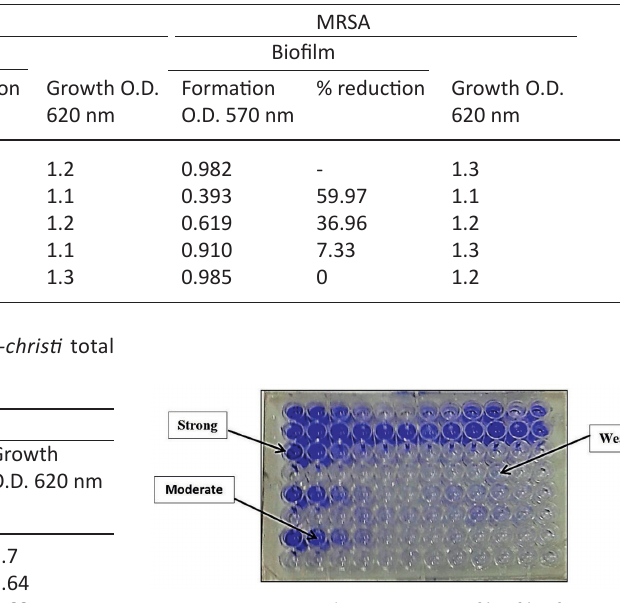
Fig. 7. Quantitative determination of biofilm formation